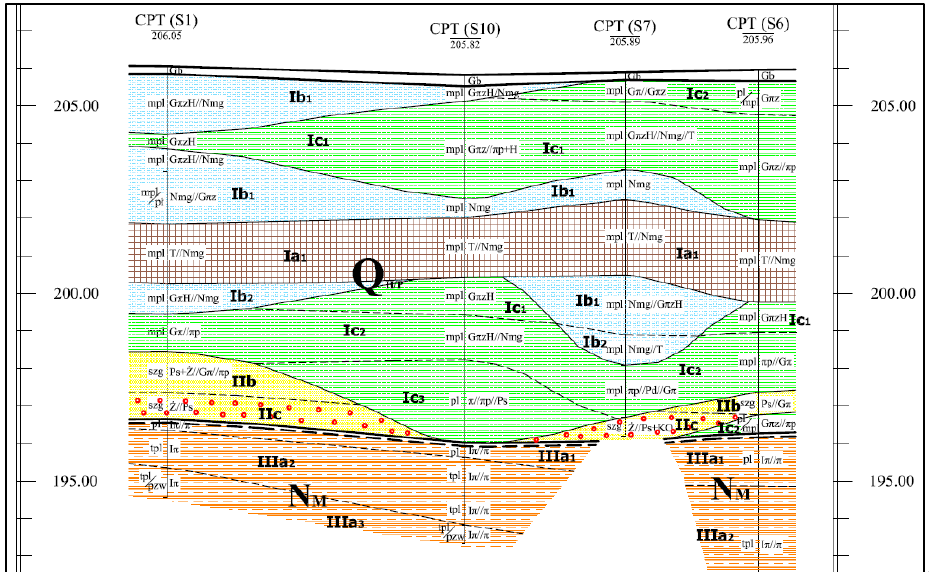
Figure 1. Selected cross-section of the local subsoil based on CPTM probes at the Rzeszow site. CPTM: cone penetration test.